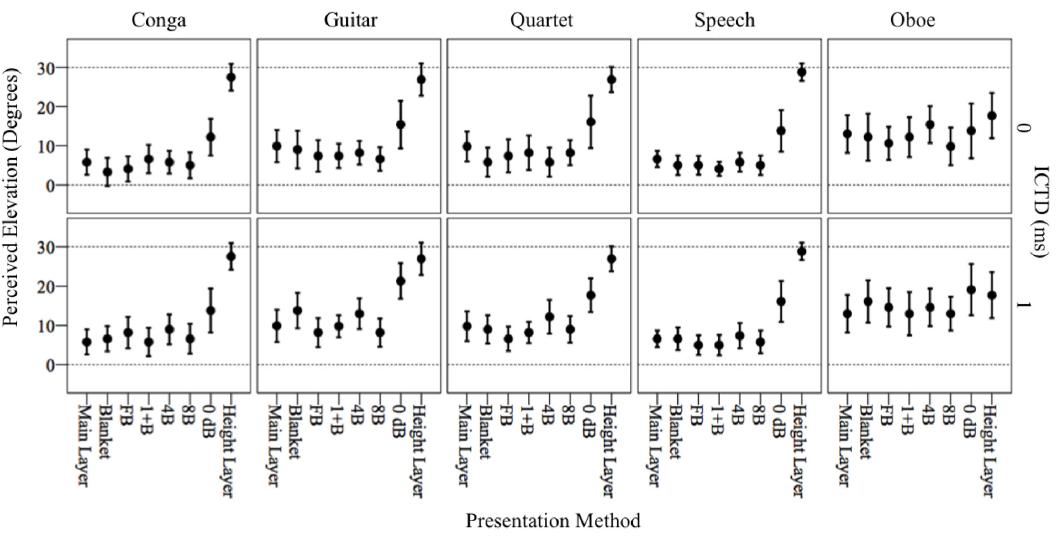
Figure 3. Median perceived elevation and associated notch edges (i.e., non-parametric 95% confidence interval) for each stimulus in the verification experiment. The dotted lines at 0 ◦ and 30 ◦ represent the positions of the main and height layers, respectively.